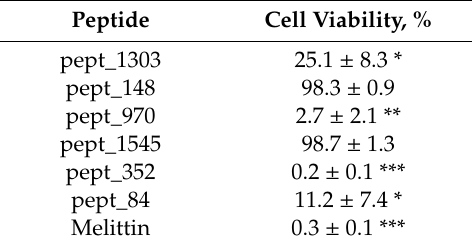
Table 3. Viability AMP-treated McCoy cells calculated from fluorescent images.